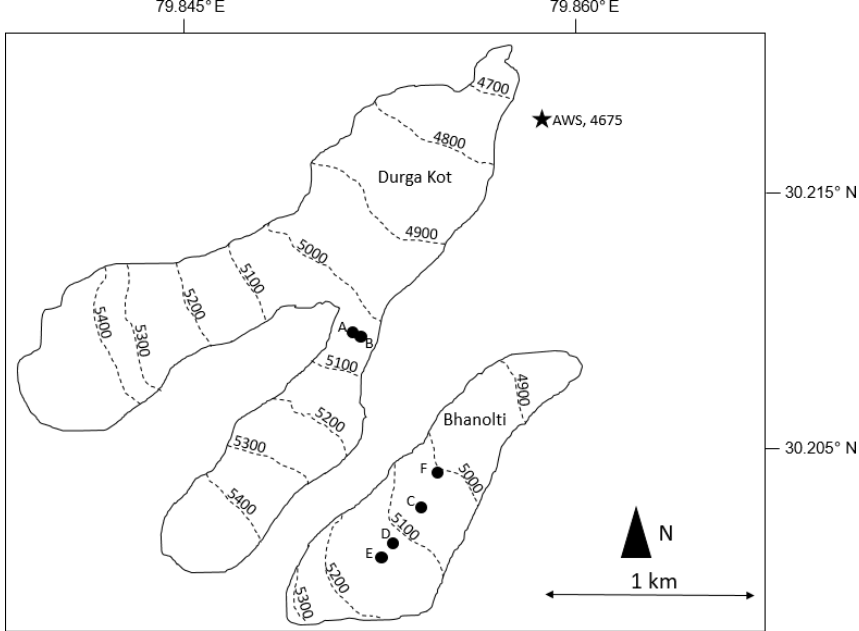
Figure 1. Map of the glaciers with the location of the snow pits (black dots), with the AWS indicated with a star. Dashed lines on the glacier refer to